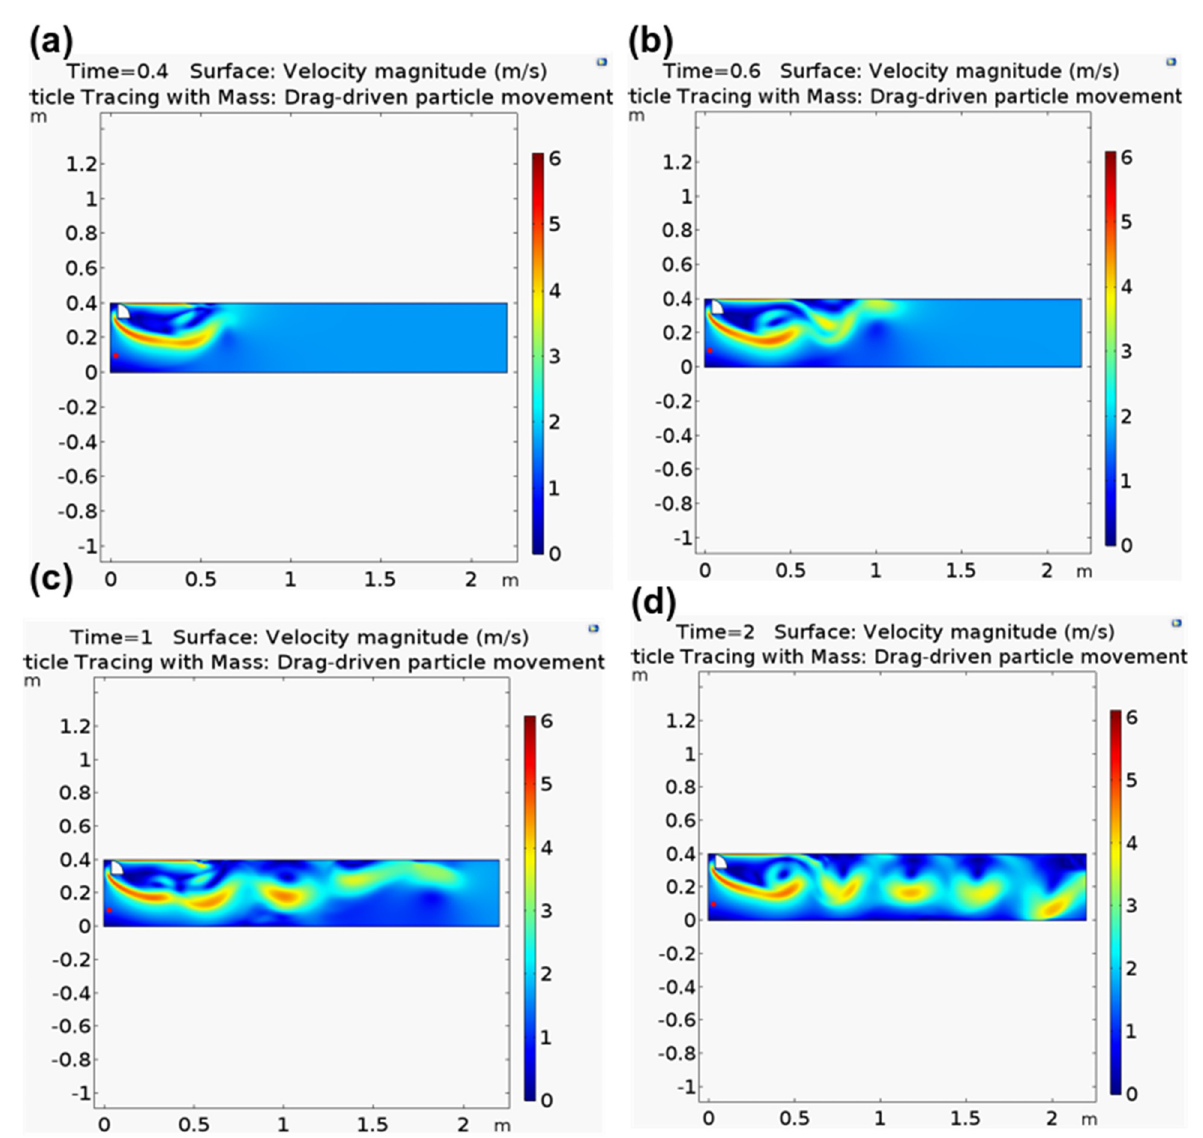
Figure 6. Anisotropic particle movement within polymer leads to some turbulence as a function of the time. ( a ) Time = 0.4; ( b ) Time = 0.6; ( c ) Time 1; ( d ) Time = 2.